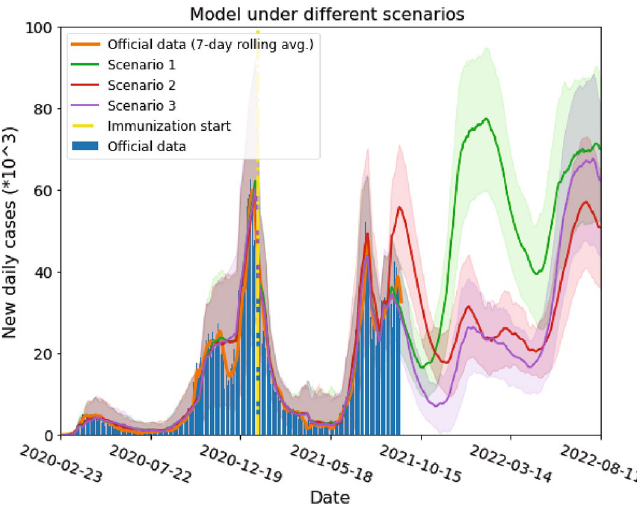
Figure 4. Model results for three different scenarios. Red, green and violet solid lines are the model simulation results under scenarios 1, 2 and 3 (see text), respectively. Shaded areas on each color represent the standard deviation from 100 model runs for each scenario. Yellow dash-dot vertical line indicates the day when immunization started. Blue bars and solid orange lines are the actual daily cases and their 7 day rolling average, respectively. In scenario 1, a short vaccination immunity period implies a growth of the daily cases in the near future, if current mobility is sustained. Under scenario 2, people are expected to be immune for a longer time and breakthrough infections will act as antibodies boosters, prolonging the defence against the pandemic. In scenario 3 most people will be immune in the near future, lowering the number of cases, and a new wave would appear when vaccine immunity